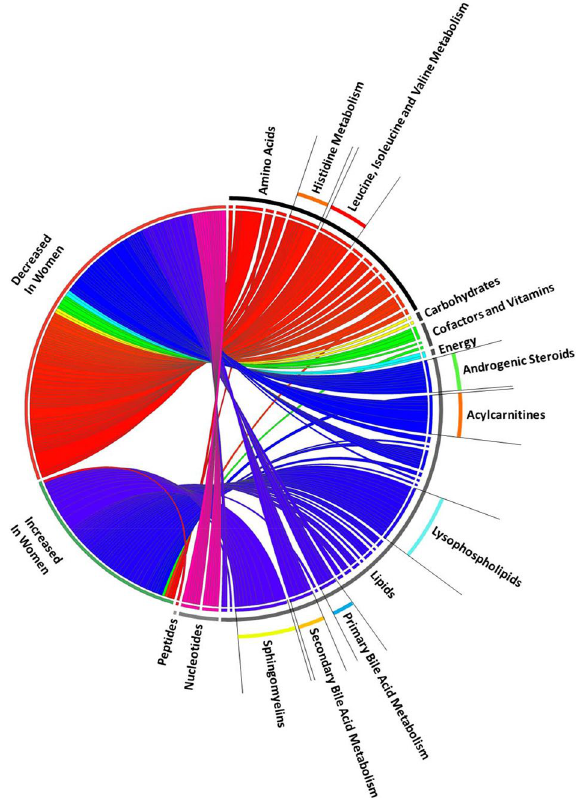
Figure 3. Circos Plot of metabolites over multiple time points. Bipartite graph of metabolites measured in 1215 plasma samples from 428 subjects. Metabolites shown are determined by mixed-effects linear regression to be significantly increased or decreased in women relative to men over the first seven days following trial enrollment. The graph connects the increase or decrease in metabolite on the left side with individual metabolites on the right side. Width of curves indicates strength of the significance (− log 10 ( P -value)) as determined by mixed-effects regression. Colors differ for each sub-pathway (i.e. all amino acid metabolites are red, all lipids are blue). All curves shown have P -value < 8.65 × 10 –5 in mixed-effects linear regression